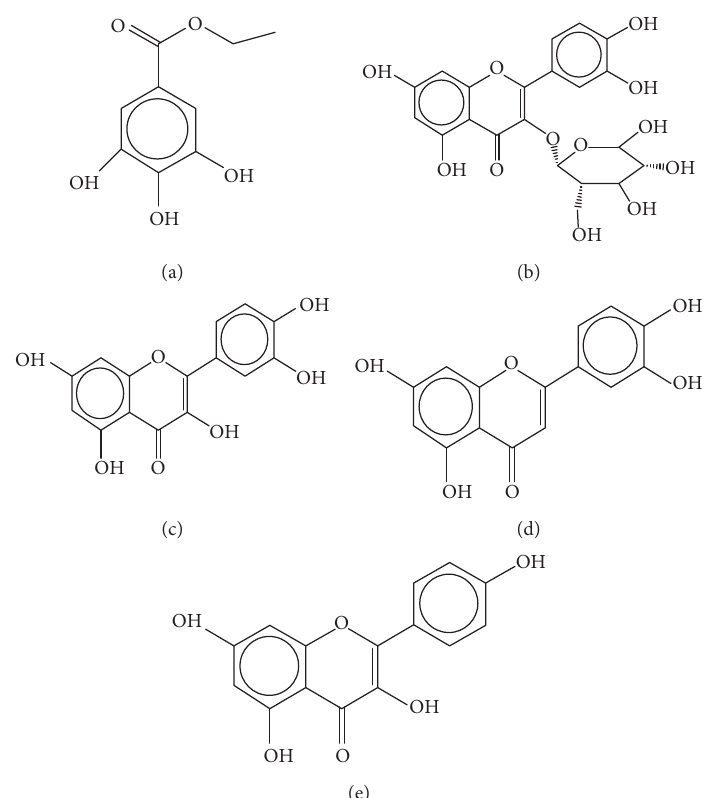
Figure 1: The structures of 5 marker constituents. (a) C